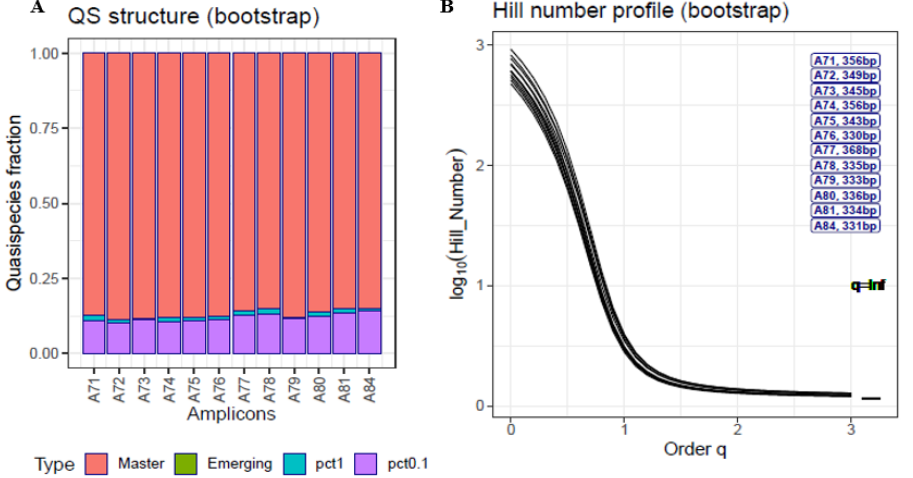
Figure 1. Quasispecies fitness fractions ( A ) and Hill number profile (HNP) plots ( B ) for a SARS- CoV-2 technical clone. The labels on the right of the HNP are sorted top-down in decreasing order of Hill number at q = 2; the ARTIC amplicon nomenclature is used (A71 to A84). Pct1 low fitness (0.1 < Freq ≤ 1%), pct0.1 very low fitness (Freq ≤ 0.1%). Each bar or curve corresponds to an amplicon of the S gene. Bootstrap values are represented. Coverage range: 51,102 – 299,349 reads; median 76,954 reads.